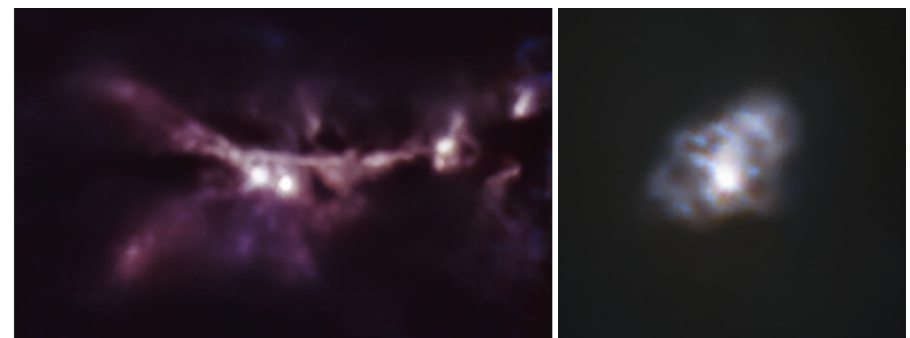
Figure 3. First results of the CONCERTO scientific commissioning. Two observations of contin- uum emission are shown as observed by the two bands of CONCERTO (1). Left plot: star form- ing region NGC6334 (Cat Paw Nebula) mapped in a field of 37 tegration. Right plot: Crab nebula observed with 2.5 minutes integration time mapped in a field Figure 2. LF (left) and HF (right) focal plane geometries. Around 90% of the designed pixels exhibit a of 10 10arcmin 2 . In both cases we represent composite images where the LF array is in blue, ⇥ beam and are healthy. and the HF array in red (ESO / CONCERTO collaboration: https: // www.eso.org / public / unitedkingdom / announcements / ann21010 /